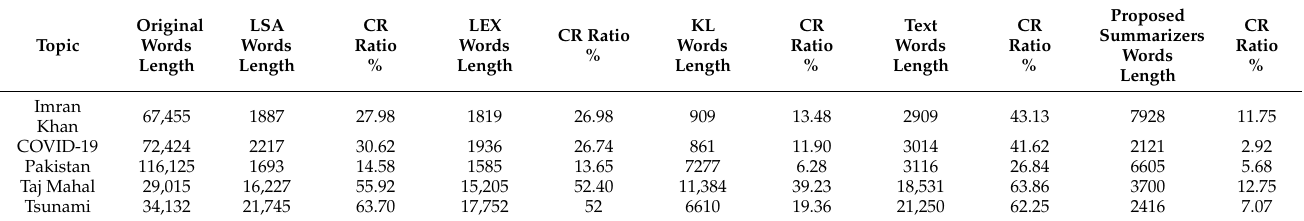
Figure 5. ( a ) Shows the number of semantic words and their frequency in the document. ( b ) Shows the number of semantic words and their frequency in the document. Table 2. The comparison of different summarizers—Shows the comparison of different summarizer with proposed